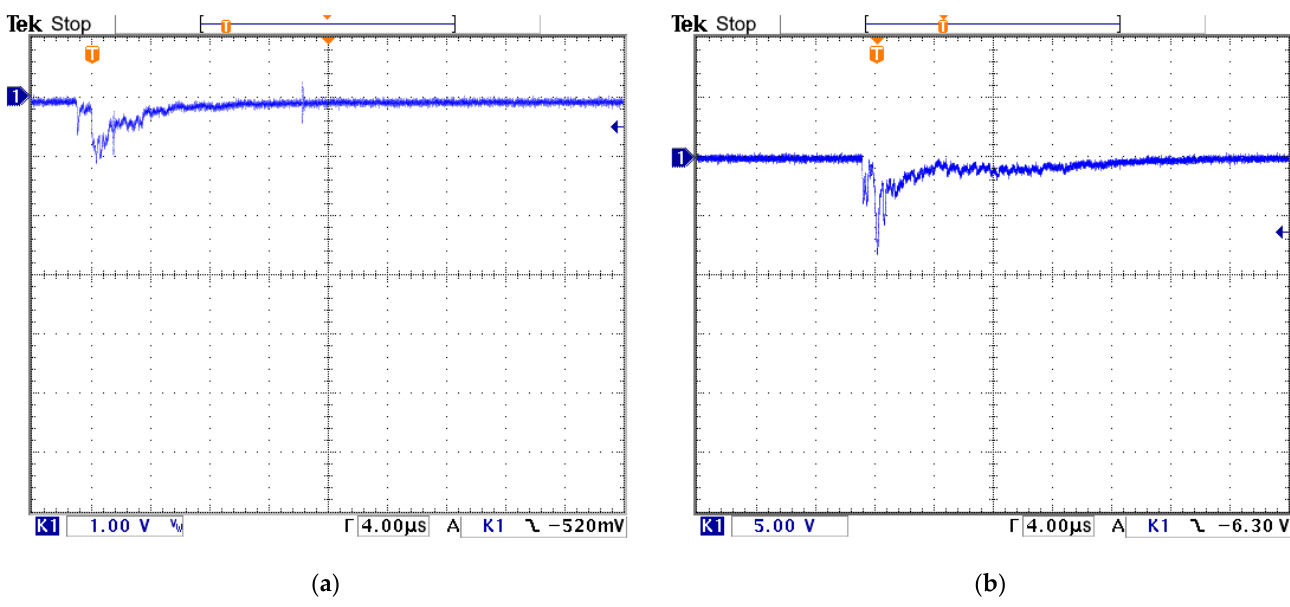
Figure 3. Oscillogram of the streamer corona current flowing through ( a ) the stem without transition into the upward leader (shunt 1.39 Ohm, 1 V/del, 4 µs/div) and ( b ) the stem with transition into the upward leader (shunt 1.39 Ohm, 5 V/del, 4 µs/div).